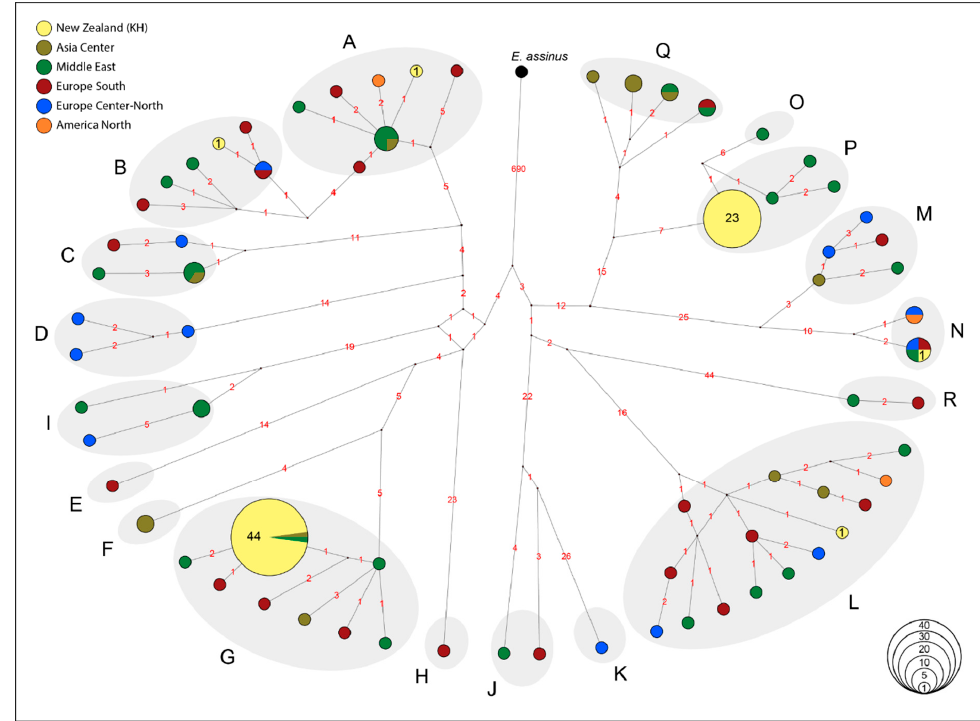
Figure 2. Median Joining network depicting mitochondrial DNA (mtDNA) haplogroup (HG) dis- tribution (A–R) in KHs in relation to the global modern horses [20], based on 1081 SNPs. Haplotypes (HT) are indicated as circles, with size proportional to their frequency. The exact number of KHs are shown inside the circles. The colors indicate the geographical origin of the samples. The number of nucleotide differences between different haplotypes are shown on each branch. Donkey ( E. assinus : NC_001788.1) mitogenome was used as an outgroup. The MJ network [28] was constructed using NETWORK v10.2.0.0 software (https://www.fluxus-engineering.com, accessed on 6 October 2022), by applying uniform substitution weights and without activating the external rooting option.